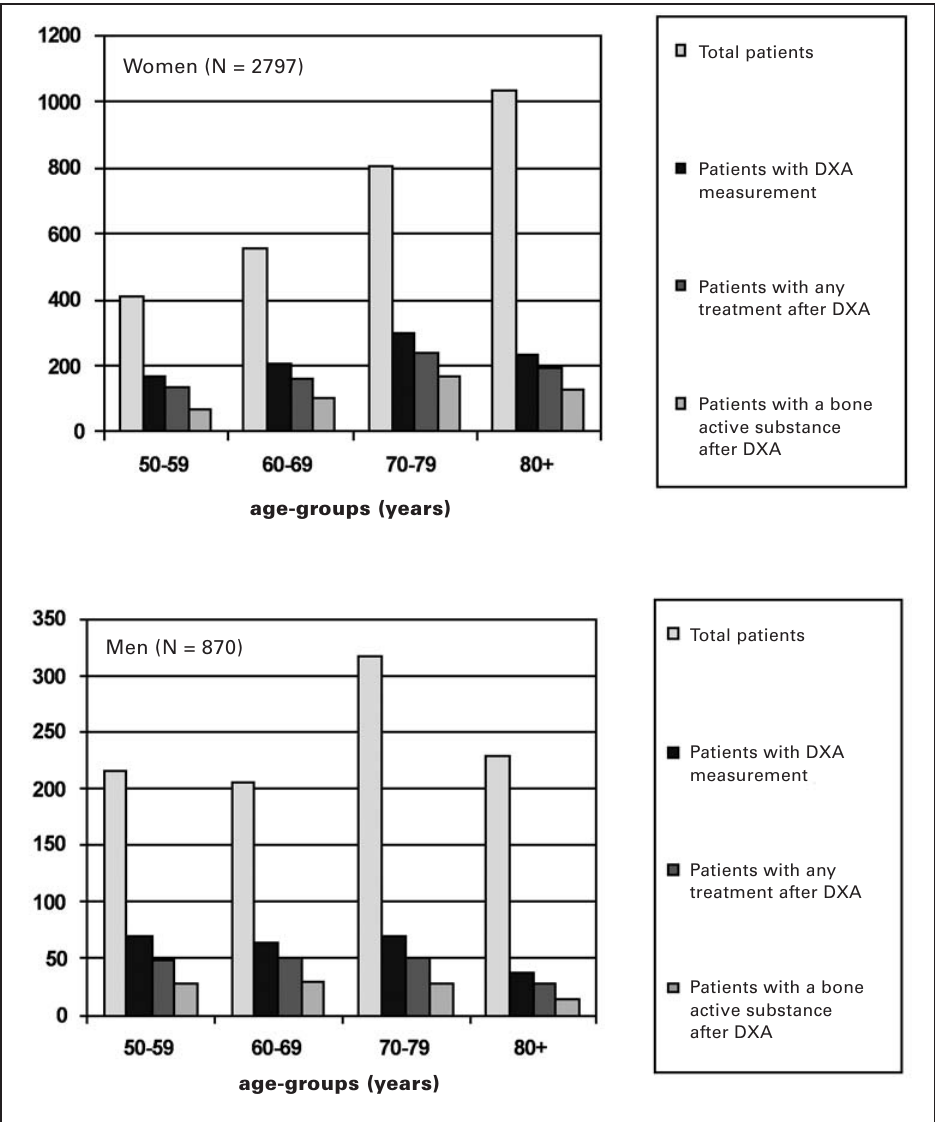
Figure 4 Fragility fractures, subsequent DXA measurement and treatment rates in women and men, by 10-year